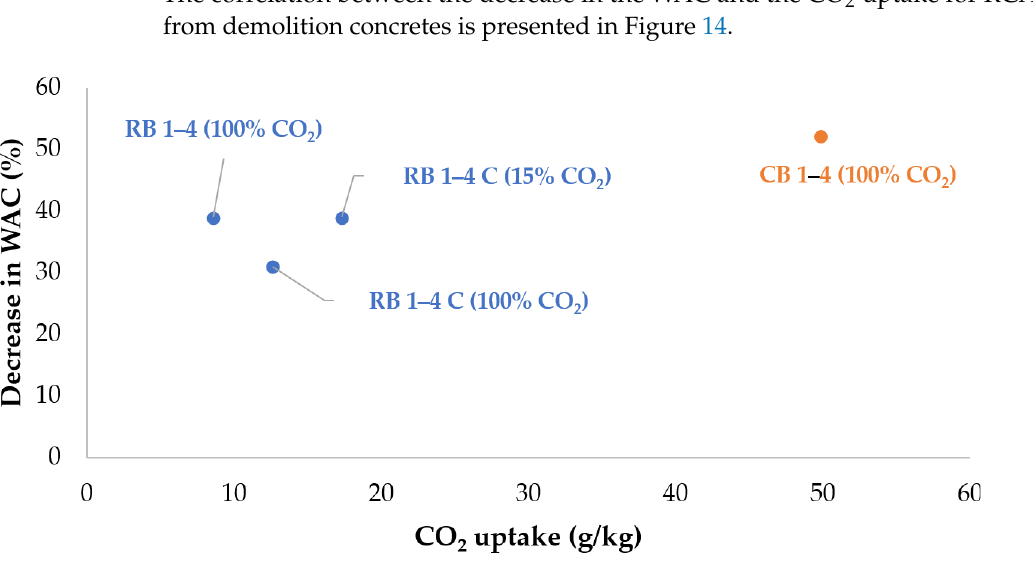
Figure 14. Relationship between the decrease in the WAC and the CO 2 uptake of RCAs sourced from demolition concretes.